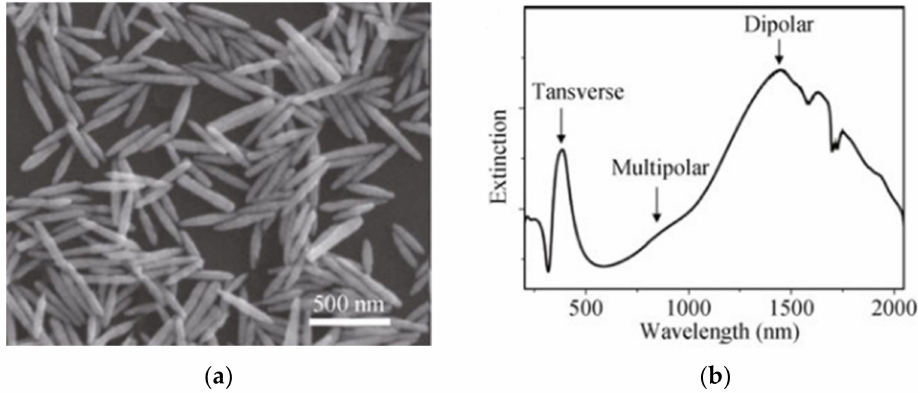
Figure 9. ( a ) SEM image of Ag nanorice; ( b ) spectral response of the nanorice ensemble showing longitudinal dipolar, multipolar, and transverse resonances. Adapted with permission from